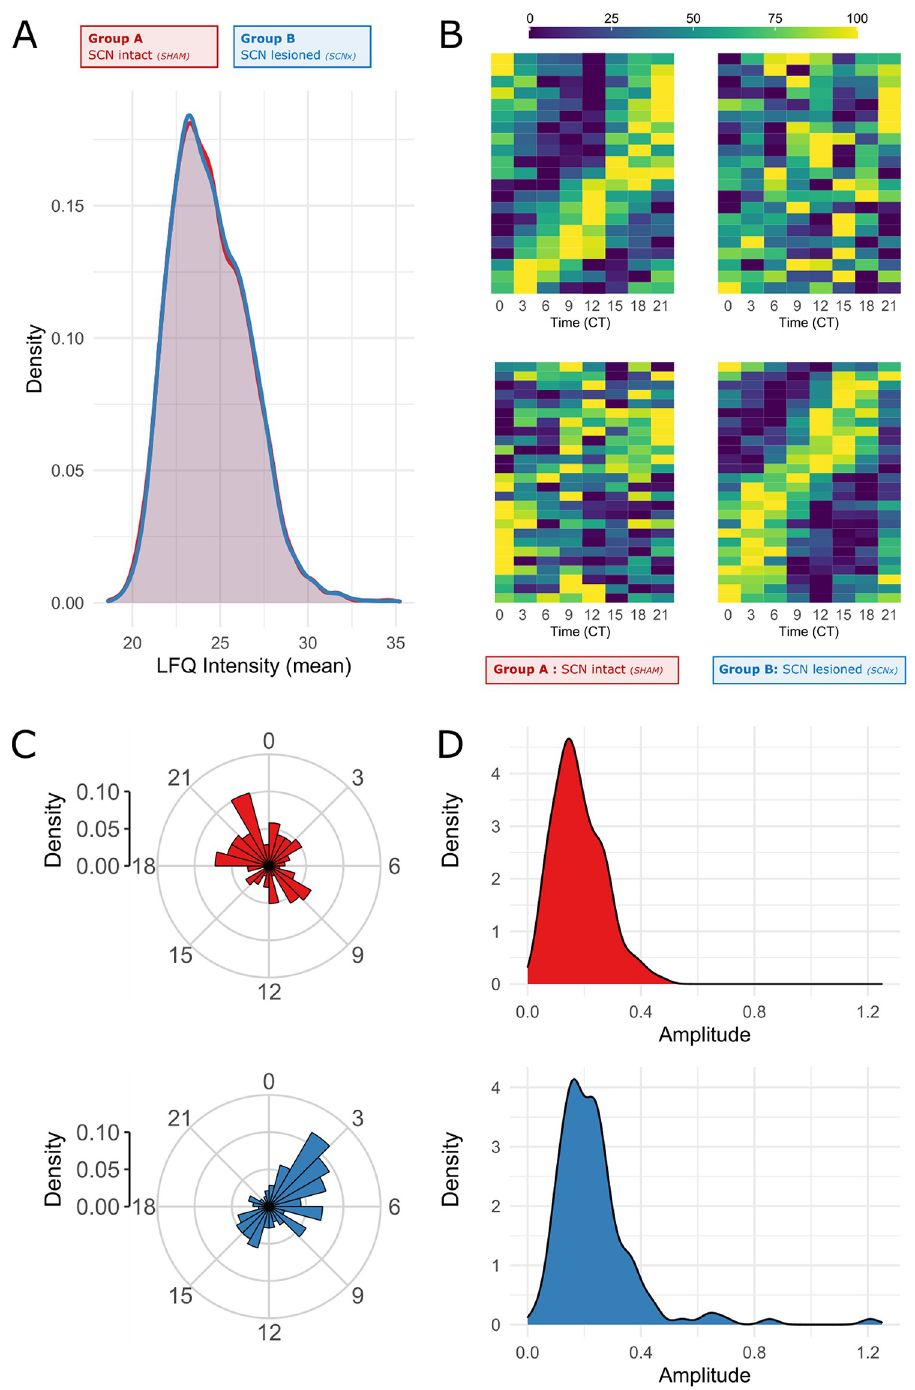
Fig 7. Proteomics. LFQ intensity values of 3,707 unique proteins detected in Groups A (SHAM, ad libitum) and B (SCN-X, tRF) across 8 time points (CT0-CT21). (A) Density plot of mean LFQ values shows similar distribution in both groups ( t test, P = 0.69) (B) Heatmaps of normalized protein levels in the fetal SCN for Groups A (left) and B (right) characterized as rhythmic via BioCycle ( p < 0.05 in Group A [top] or Group B [bottom]). (C) Phase and (D) amplitude distribution of proteins rhythmic in Group A (red) and Group B (blue). For raw data, see S5 Data. LFQ, label-free quantification; SCN, suprachiasmatic nuclei.